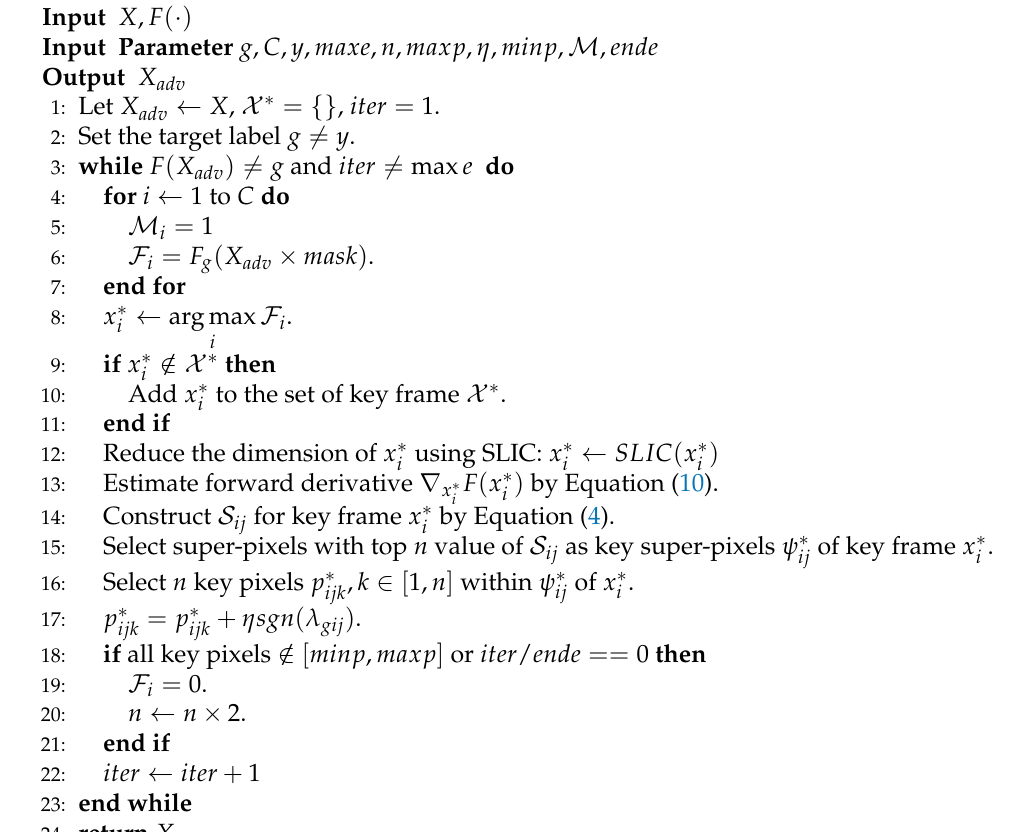
Algorithm 2 Crafting the Black-Box Attack in the Target